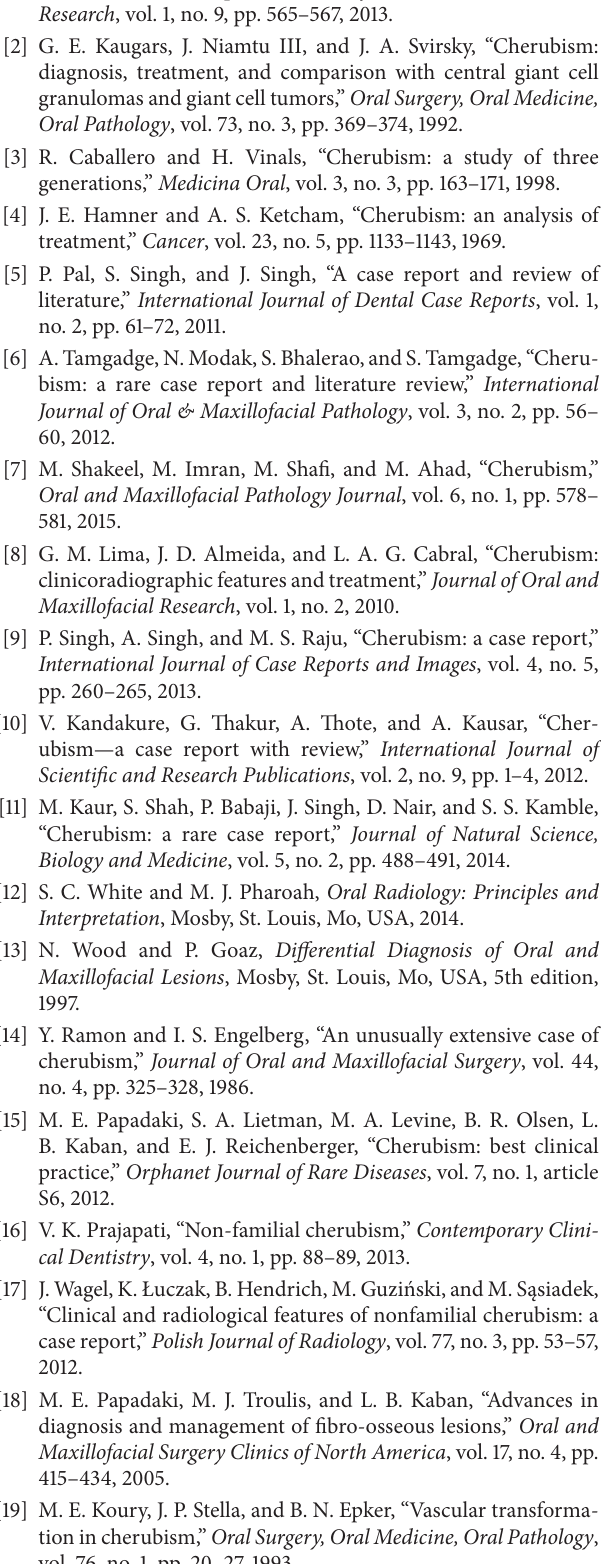
Figure 5: Histopathological evaluation of the lesion.